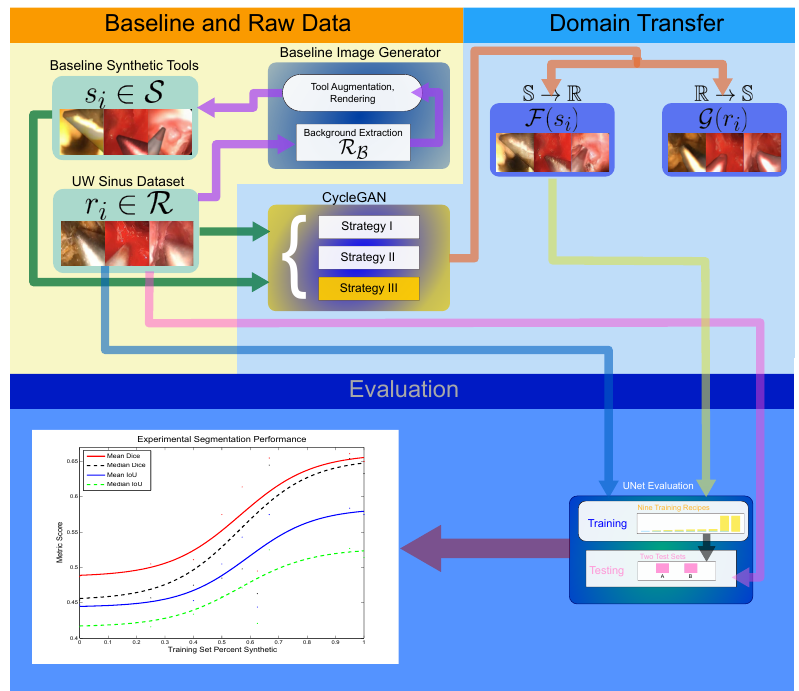
Figure 6. The GAN-driven synthetic image generation framework for endoscopic surgical tool